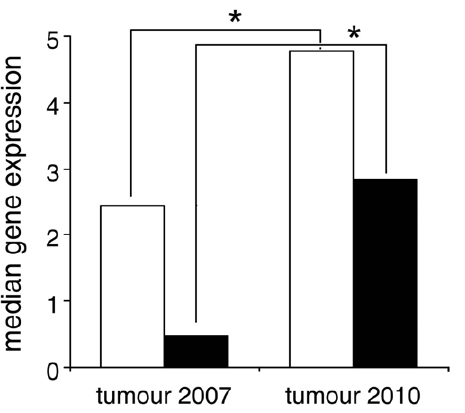
Figure 6. TERT and TINF2 gene expression increases with time in DFT samples. Open bars depict TERT expression, black bars depict TINF2 expression. Number of samples used in the analysis: tumours collected in 2007: N=5 and 2010: N=6. * depicts significant differences (P=0.0173 and P=0.013, respectively).